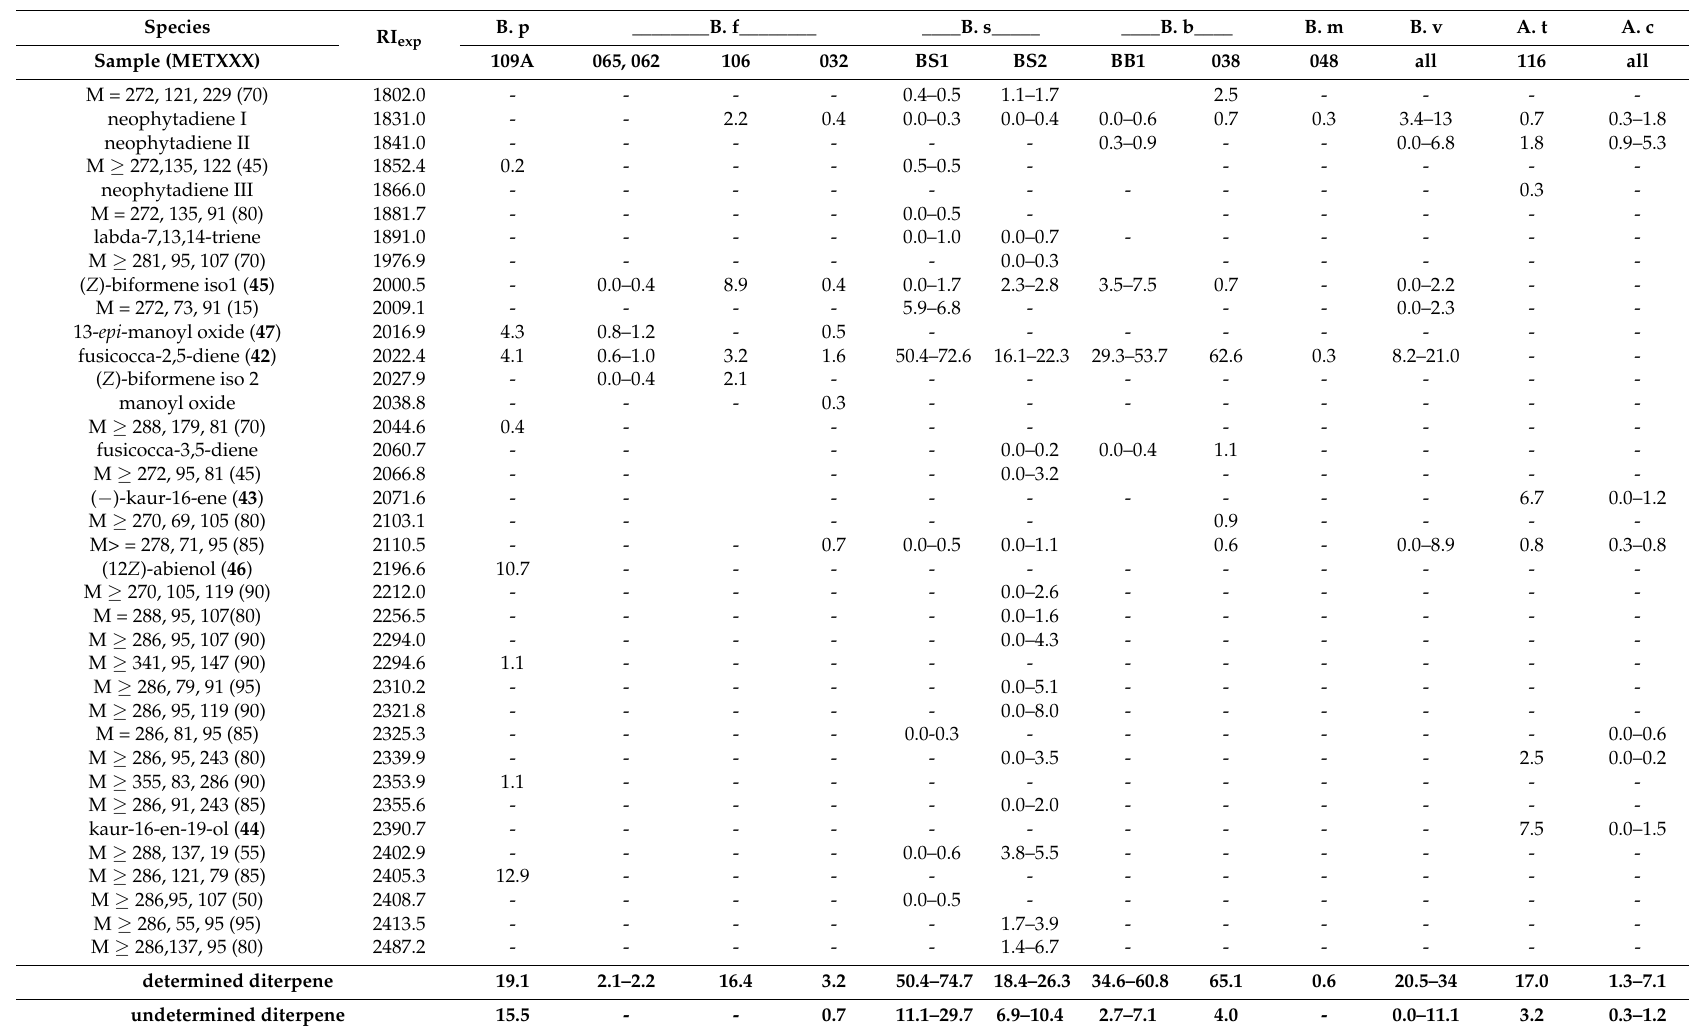
Table 9. Diterpene composition (relative percentage, %) of the analyzed